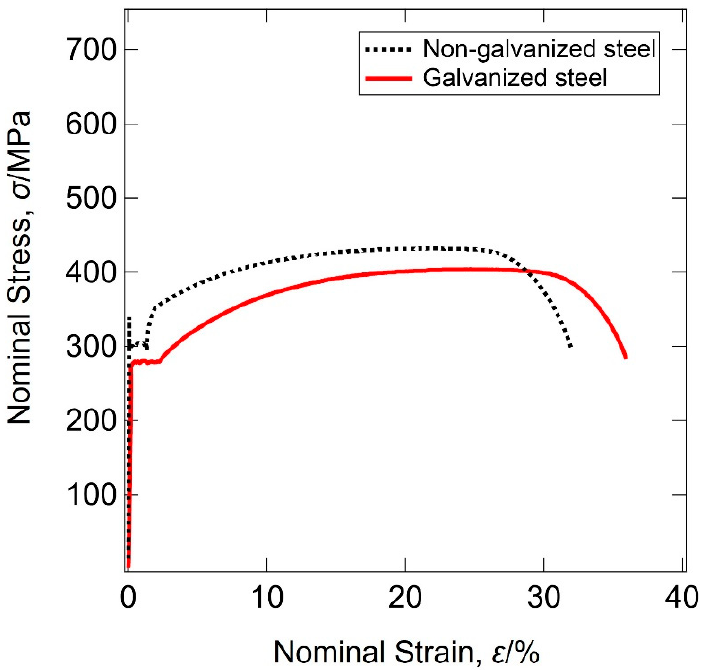
Figure 4. Stress–strain curves for the normalized AISI 1020 steel before and after hot-dip galvaniz- ing.